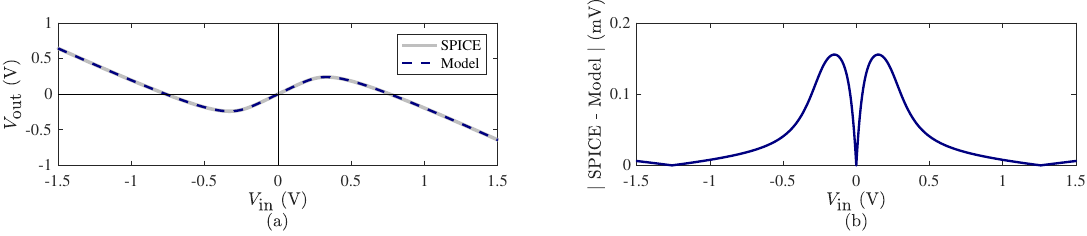
Figure 7. ( a ) Transfer function of a single wavefolding stage in the Serge middle VCM measured using SPICE and the proposed model; and ( b ) the absolute difference between these two